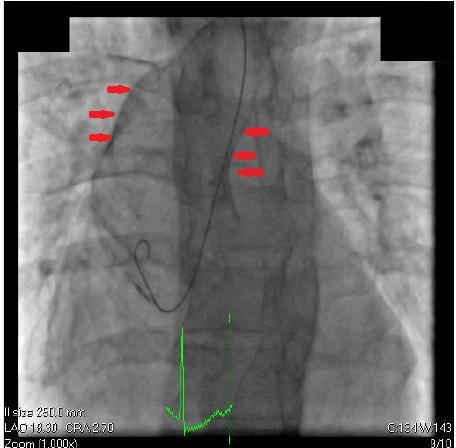
Figure 6. Fluoroscopy during coronary angiography detected aortic calcification highly suggestive of porcelain aorta (PA). The red arrows point the aortic walls.